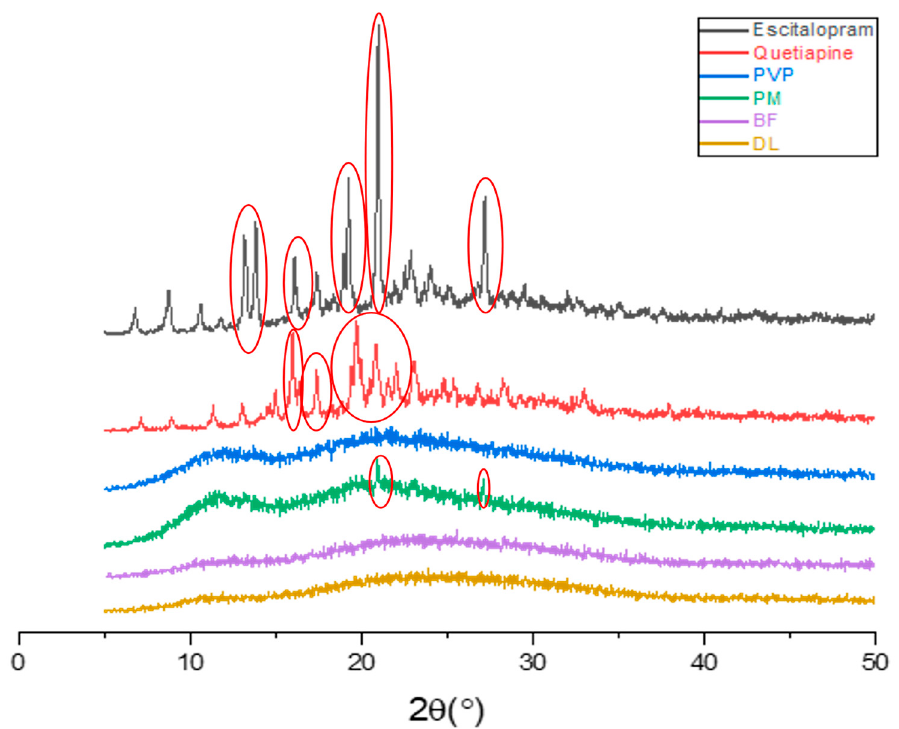
Figure 4. XRD diffraction patterns of ESC, QUE, PVP, physical mixture (PM), blank fibers (BF), and drug-loaded fibers (DL), showing that both drugs have distinctive peaks, indicating that they are in the crystalline form, while the polymer is in the amorphous form represented by broad halos. There are distinctive peaks in the PM representing both drugs which lacked in the BF and DL coaxial fibers (broad halos), indicating the molecular dispersion of both drugs in the DL.